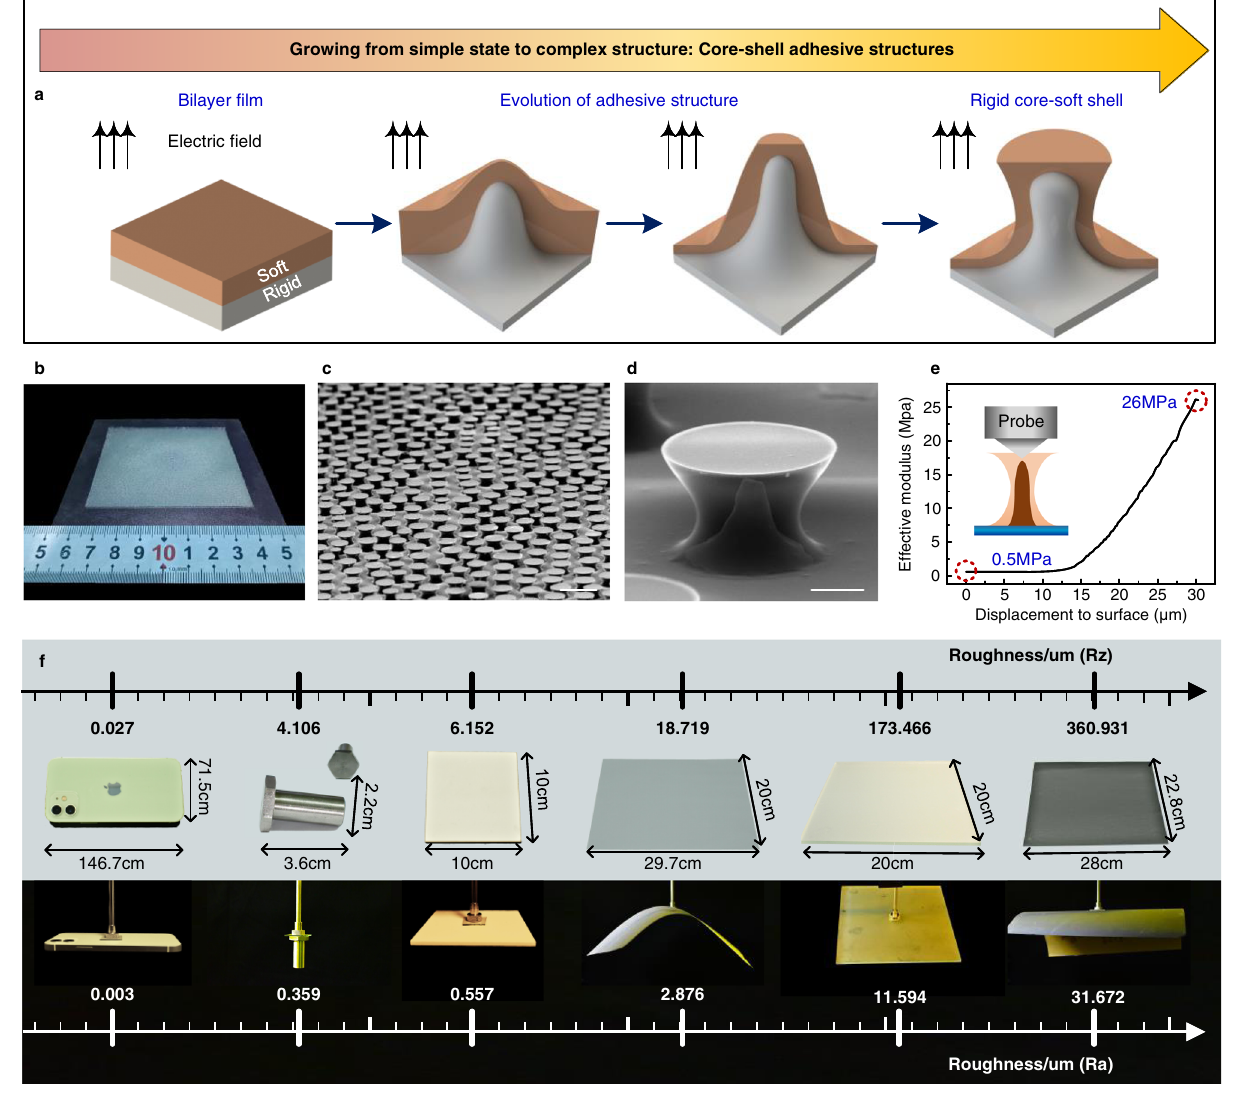
Fig.1|Schematicoftheself-growthofadhesivestructureswitharigidcoreand asoftshell.a Schematicofthegrowthprocessoftheproposedcore – shelladhesive structure under the action of an external electric fi eld. b Photograph of the grown mushroom-shaped structures with a rigid coreand a soft shell:the structures have an area of 7×7cm 2 , and TPU and silicon rubber are adopted as the rigid and soft materials,respectively. c Distributionofthegrowncore – shellstructuresexhibiting a short-range order. The scale bar is 500 μ m. d Synthetic image of the grown